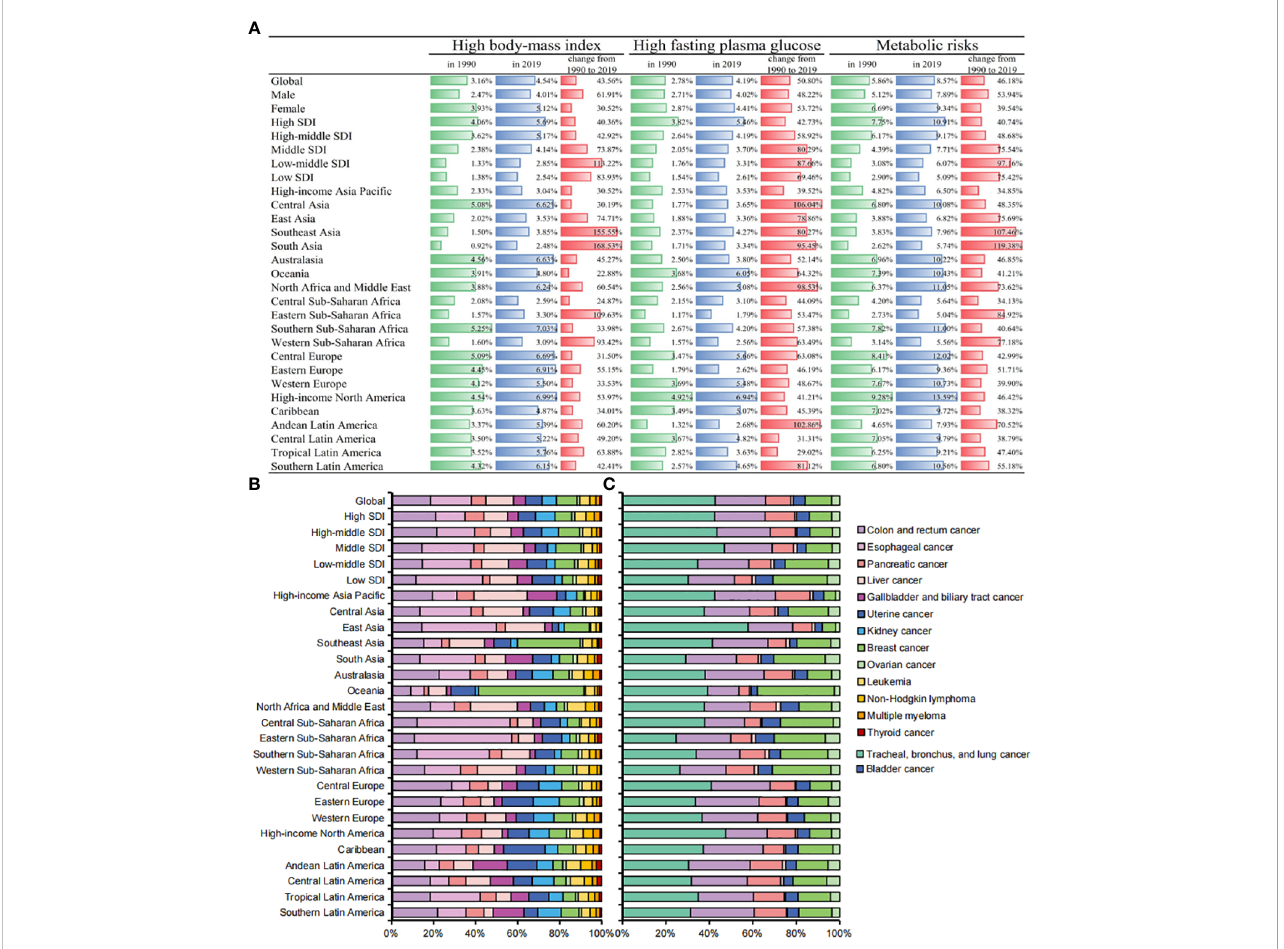
FIGURE 5 (A) Percentages of ASDRs in cancers attributable to metabolic factors by SDIs and GBD regions in 1990, 2019, and changes from 1990 to 2019. (B) Contributions of different cancers to total cancer deaths attributable to high-body mass index by SDIs and GBD regions in 2019. (C) Contributions of different cancers to total cancer deaths attributable to high fasting plasma glucose by SDIs and GBD regions in